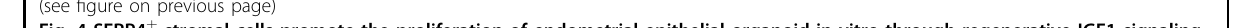
the immuno fl uorescence staining with SFRP4 and CD10 (Fig. 3d), approximately 97.28% of the cultured endo- metrial stromal cells were SFRP4 and CD10 double- positive cells (Fig. 3e), which was consistent with the single-cell data showing that most of the stromal cells in the proliferative phase of the endometria were SFRP4 + endometrial stromal cells (Supplementary Figs. S4c, S5).